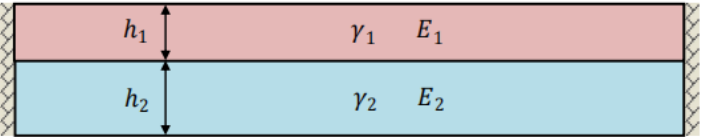
Figure 10. Model of a two-layer system.